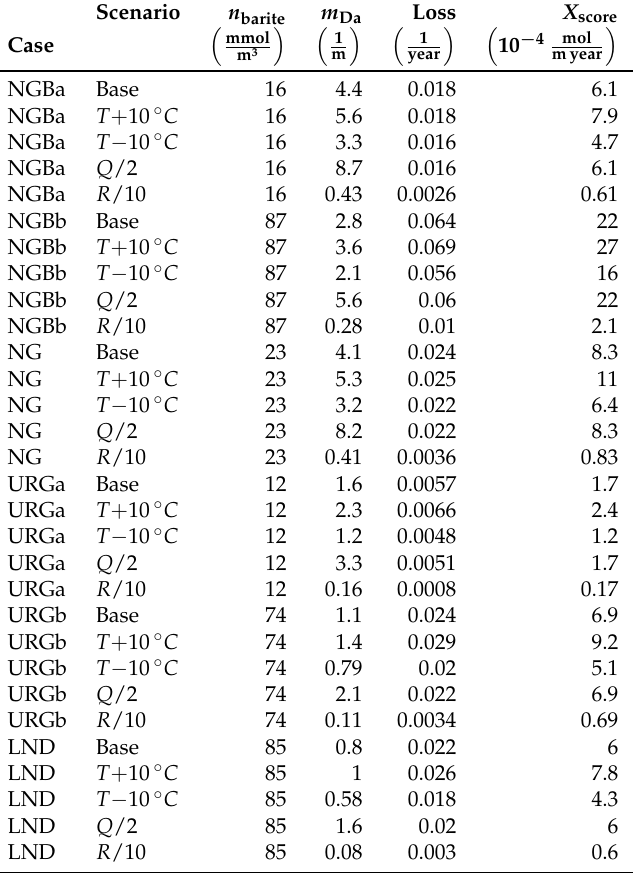
Table 4. Summary of results of the equilibrium calculations and the reactive transport simulations for all considered geothermal cases and scenarios. Further, the developed empirical scaling score X score is shown (Equation